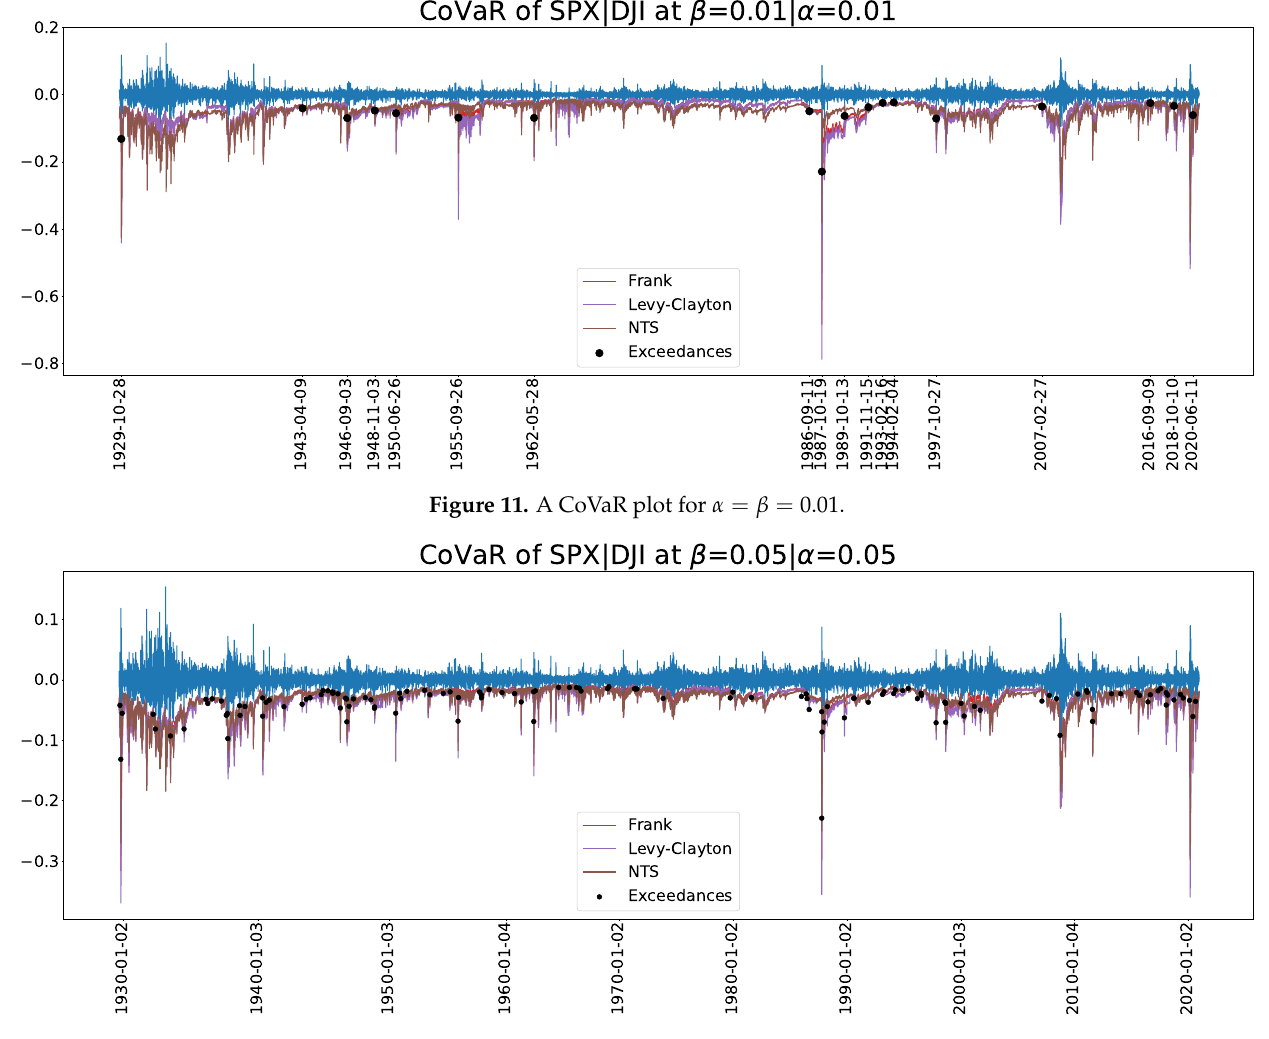
Figure 12. A CoVaR plot for α = β =